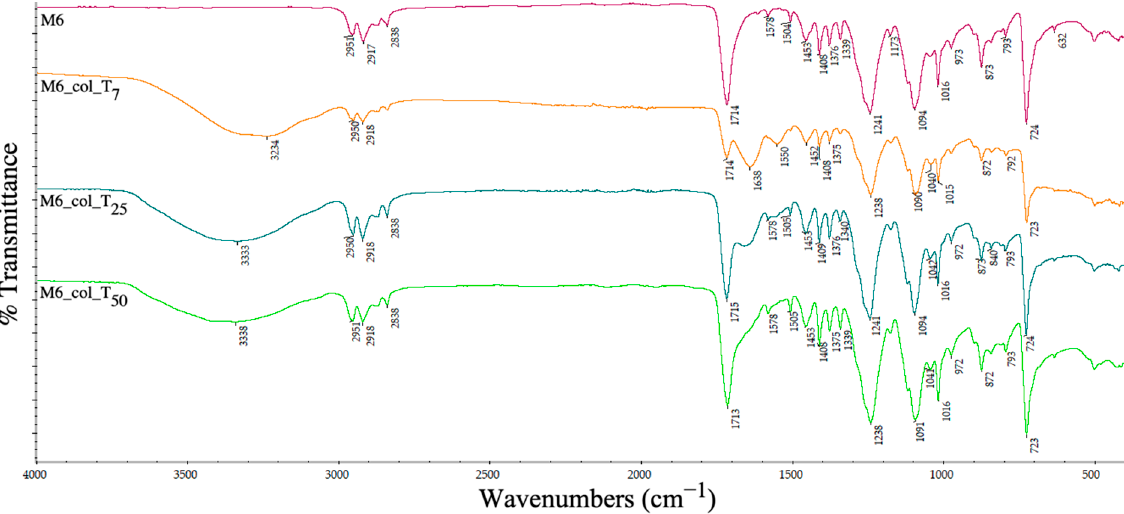
Figure 20. ATR spectra of PET–PP composite pellets before and after collagen deposition at days 7 (T 7 ), 25 (T 25 ) and 50 (T 50 ).